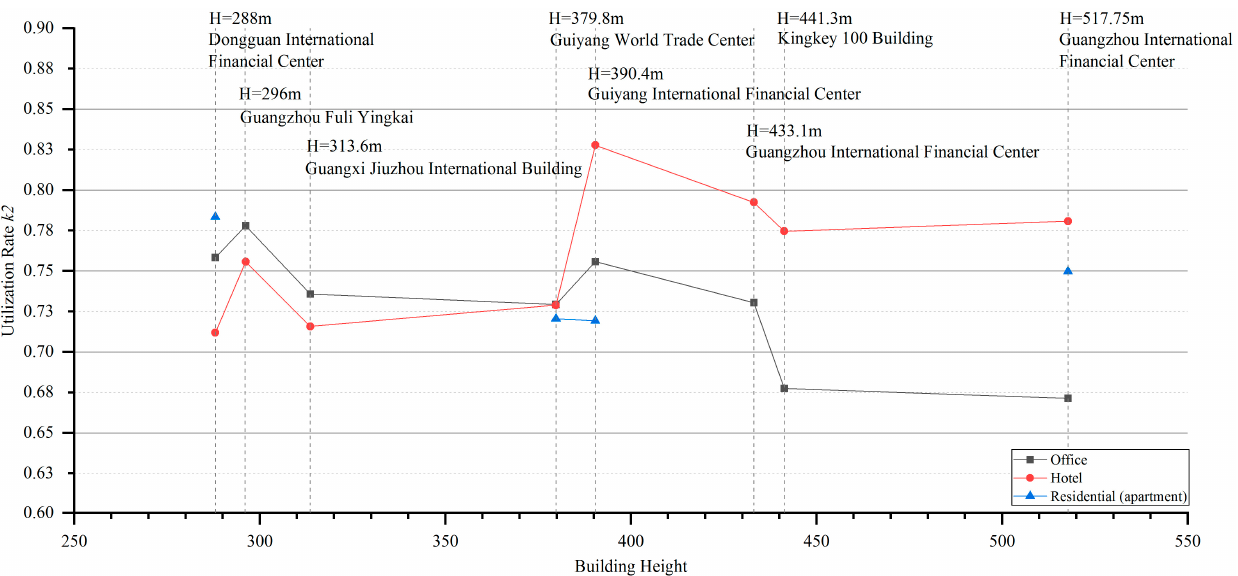
Figure 22. Statistics of the area of different business types (in m 2 ).